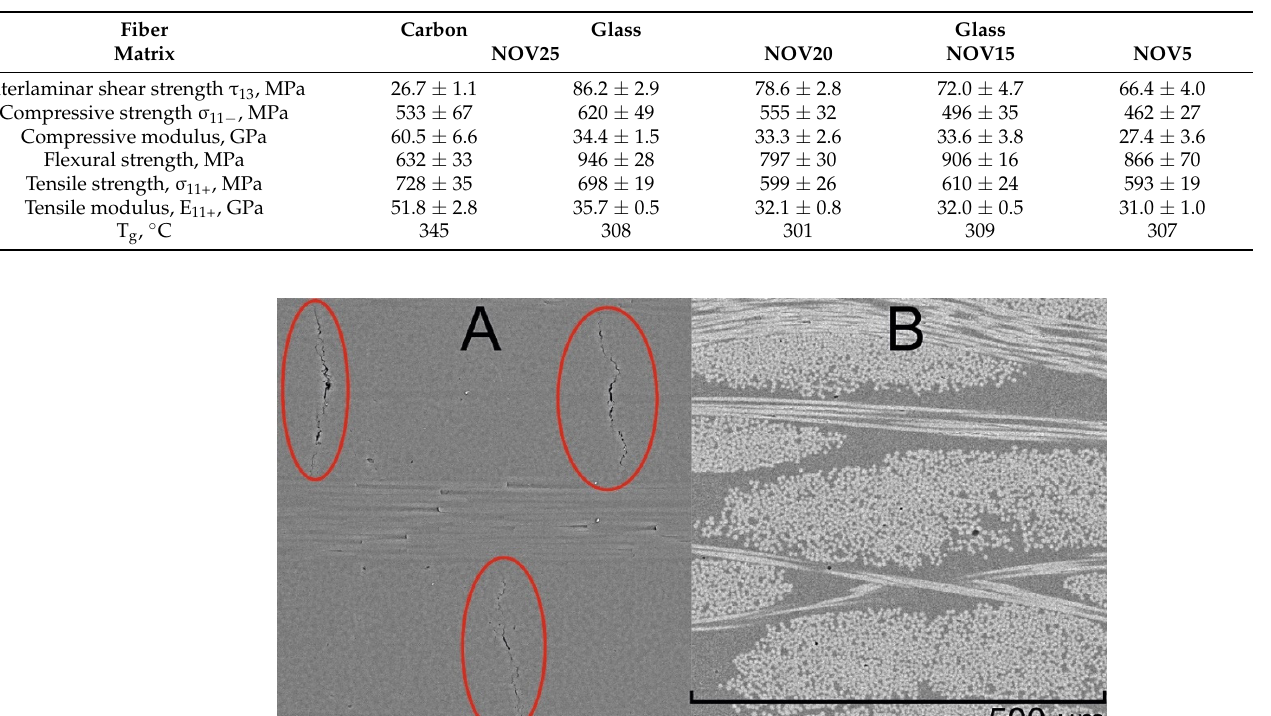
Table 3. Mechanical properties of FRPs plied with [0] n orientation at 0° direction.